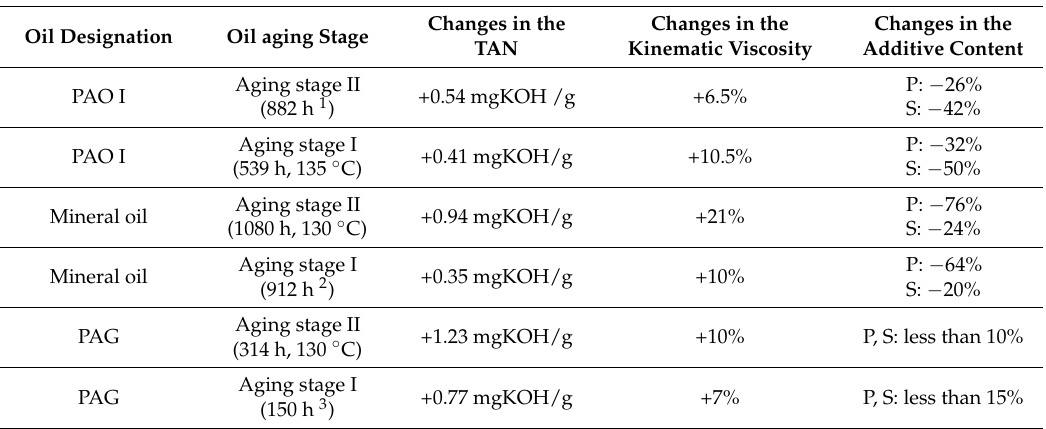
Table 4. Results of the laboratory